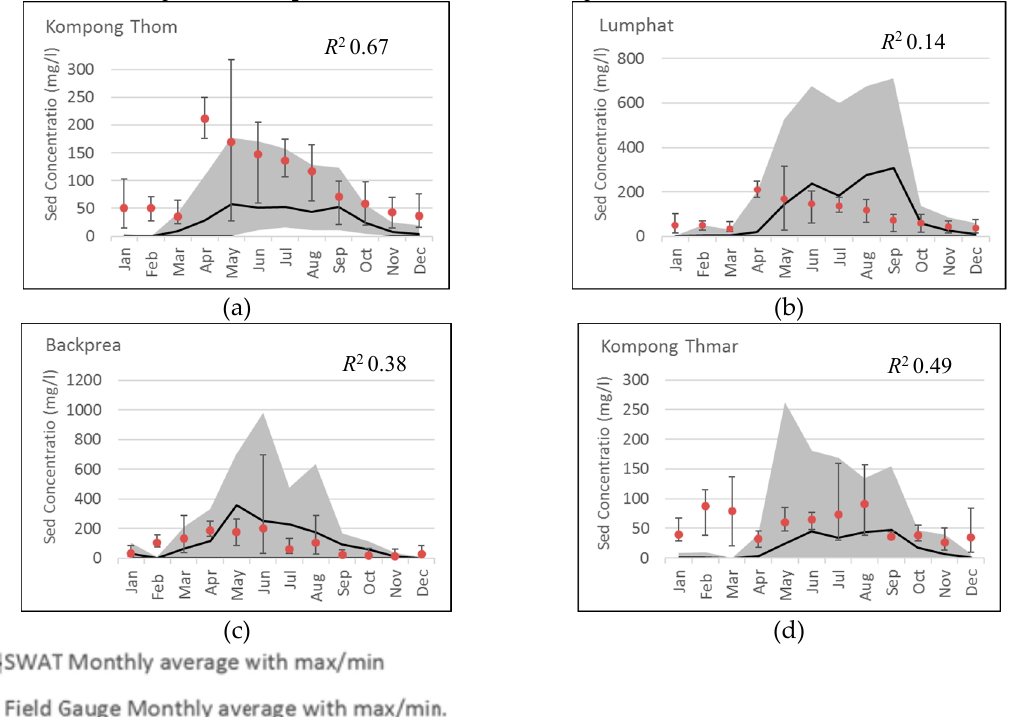
Figure 4. Calibration of the SWAT model’s sediment (Sed.) concentration at 4 MRC gauging stations (( a ), Kompong Thom, ( b ) Lumphat, ( c ) Backprea, ( d ) Kompong Thmar). The charts compare SWAT monthly average (black line) with min and max (gray), and actual MRC average (red point) with error bars showing min and max.